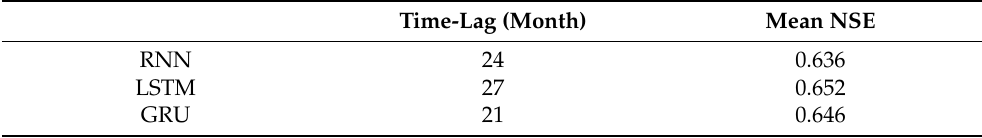
Figure 11. NSE value of ( a ) RNN, ( b ) LSTM, and ( c ) GRU with different time lags (3, 6, 9, 12, 15, 18, 21, 24, 27, and 30 months) at monthly prediction. Table 7. The optimal time-lag settings at monthly prediction.